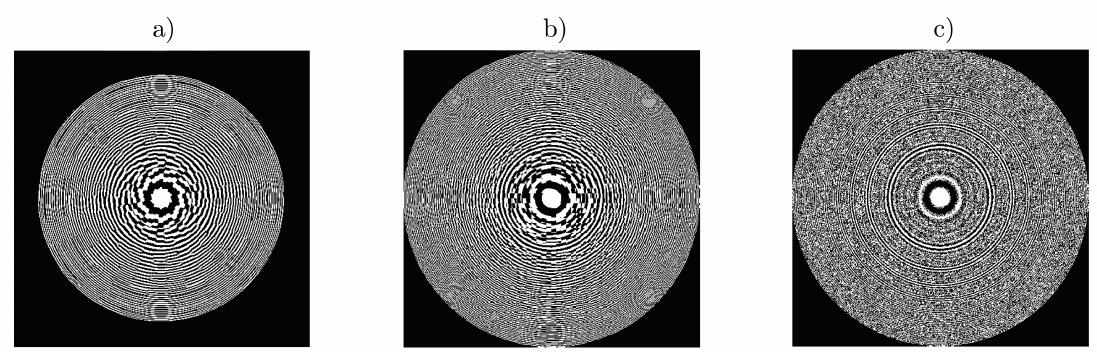
Figure 9. Achromatic lenses multiplexing schemes: ( a ) 30 sectors in three zones; ( b ) random multiplexing 8 × 8 pixels and ( c ) random multiplexing 1 × 1 pixels.